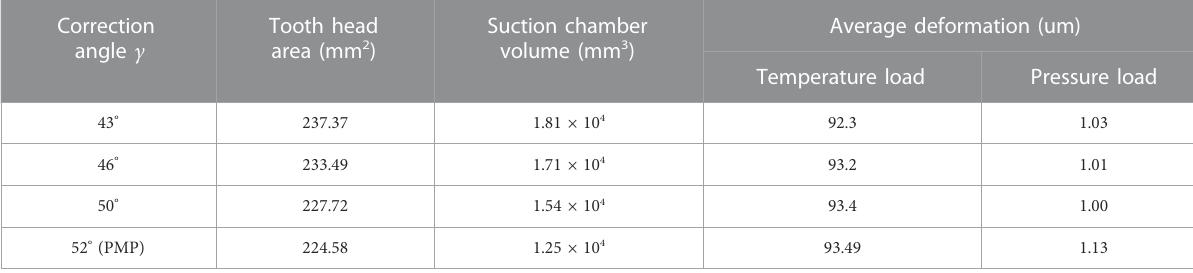
TABLE 5 The data of tooth heads with different correction